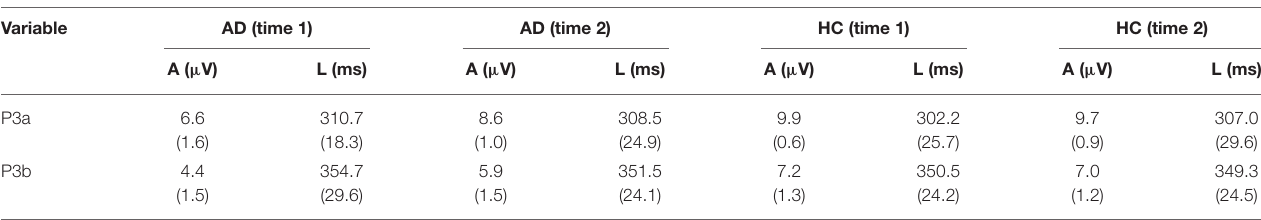
TABLE 2 | ERP data [mean (SD)] in the AD group ( n = 30) and HC group ( n =